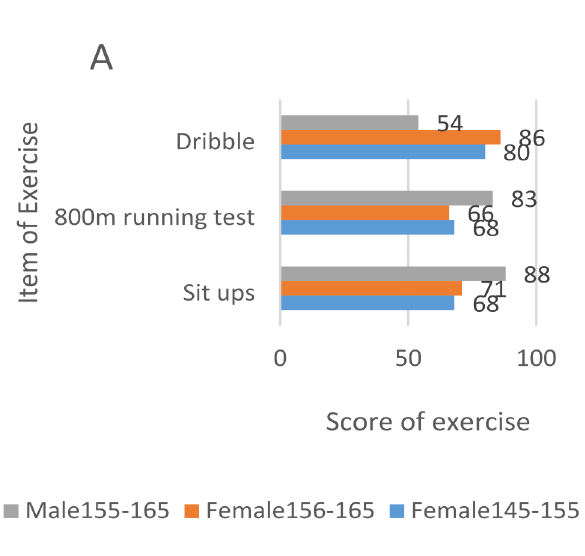
Figs. 7 A comparison of sit-ups, 800 m running tests and dribbling A. Data results of sit-ups, 800 m running tests and dribbling before training. B. Data results of sit-ups, 800 m running test and dribbling training.